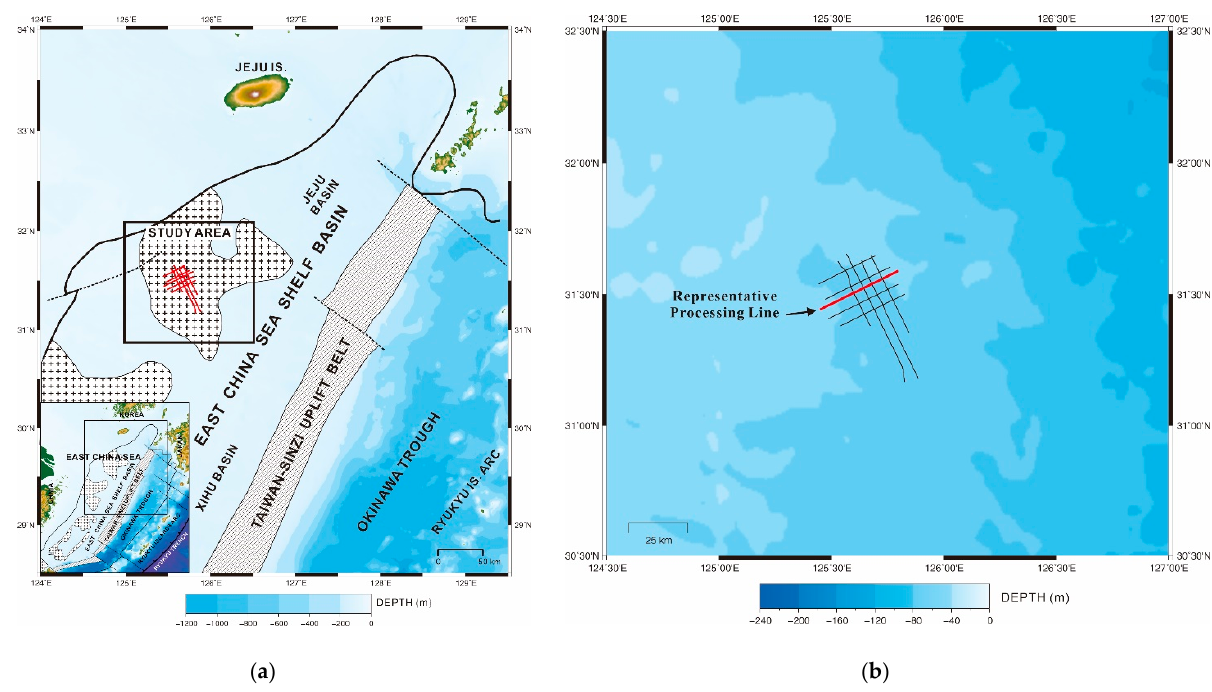
Figure 1. ( a ) Survey area map and ( b ) seismic acquisition lines (modified from [24]). The bold red line is a representative seismic processing line.